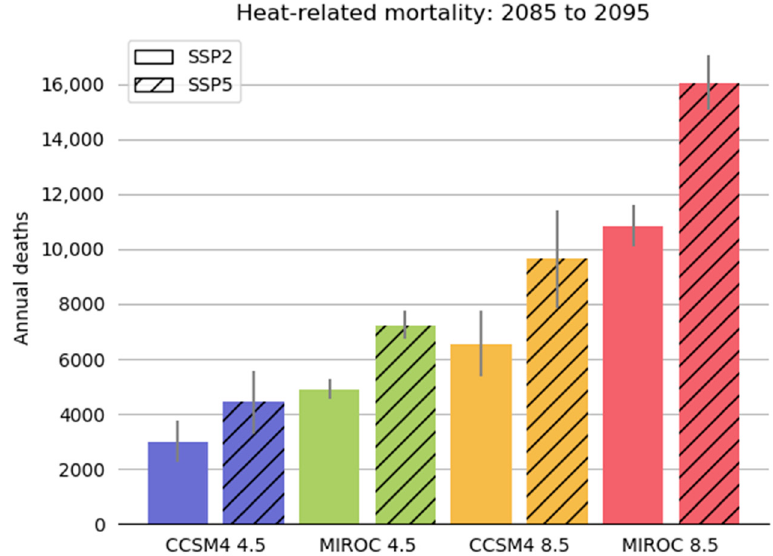
Figure 6. National BenMAP modeling results. The columns represent annual mortality averaged over 11 years. The thin vertical lines represent the range in annual heat mortality estimates.